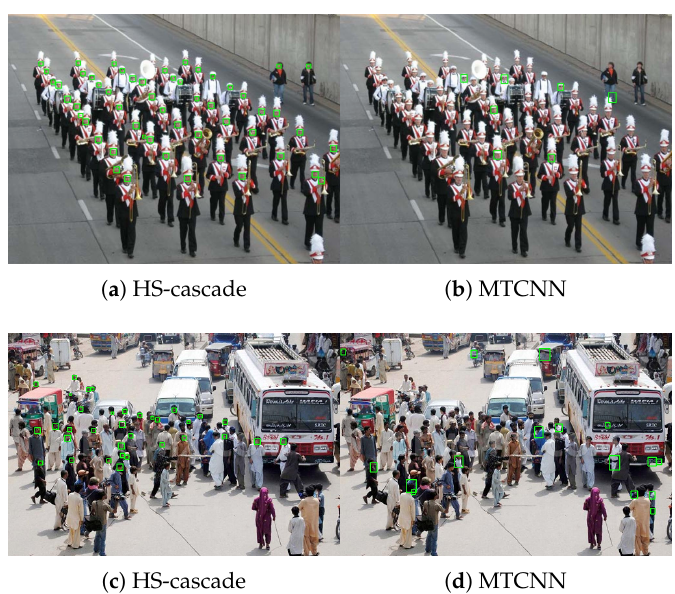
Figure 12. Comparison between HS-cascade and MTCNN on the WIDER FACE dataset.